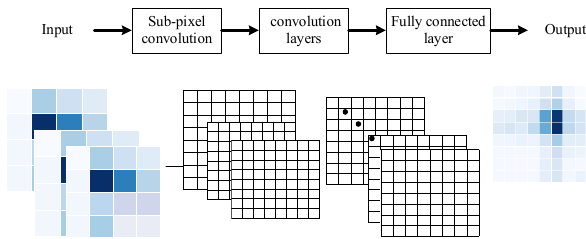
Figure 5. The LSTM estimation model of this paper.